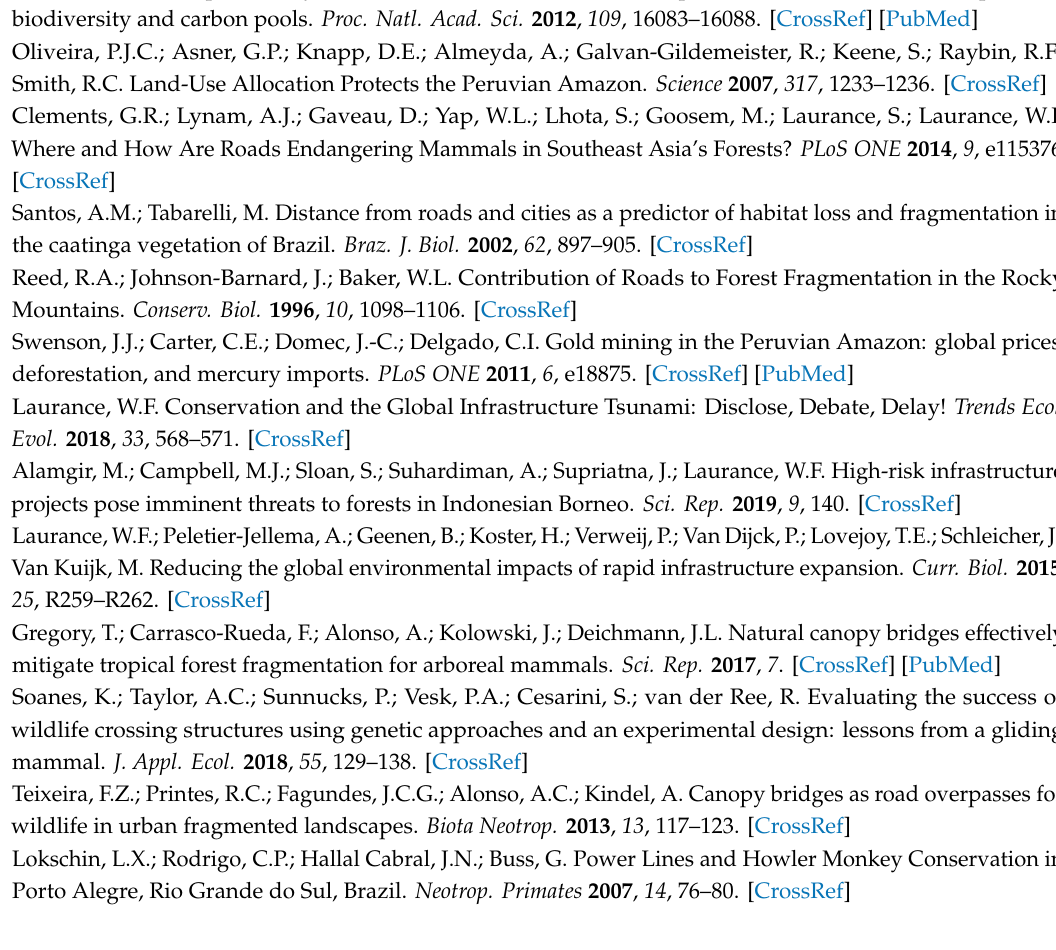
Figure S1. The four species that used the NCBs the most: ( a ) Potos flavus , ( b ) a group of three Aotus nigriceps , ( c ) Caluromys lanatus , and ( d ) Bassaricyon alleni with o ff spring, Figure S2. Pygmy anteater ( Cyclopes didactylus ) crossing an NCB, Table S1. Information on canopy bridges and their maintenance over the course of the 14-month study, Table S2. Bird and reptile species detected in camera trap images in the NCBs and the SACB, with the number of events and the trapping rate